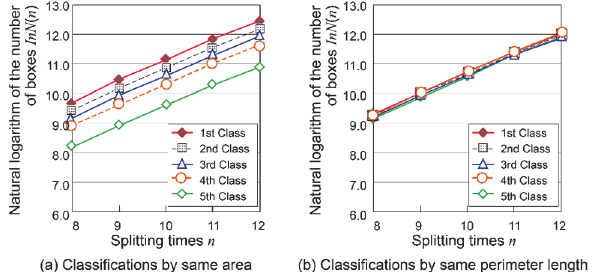
Figure 9 . Conformation of fractal properties in virtual maps.